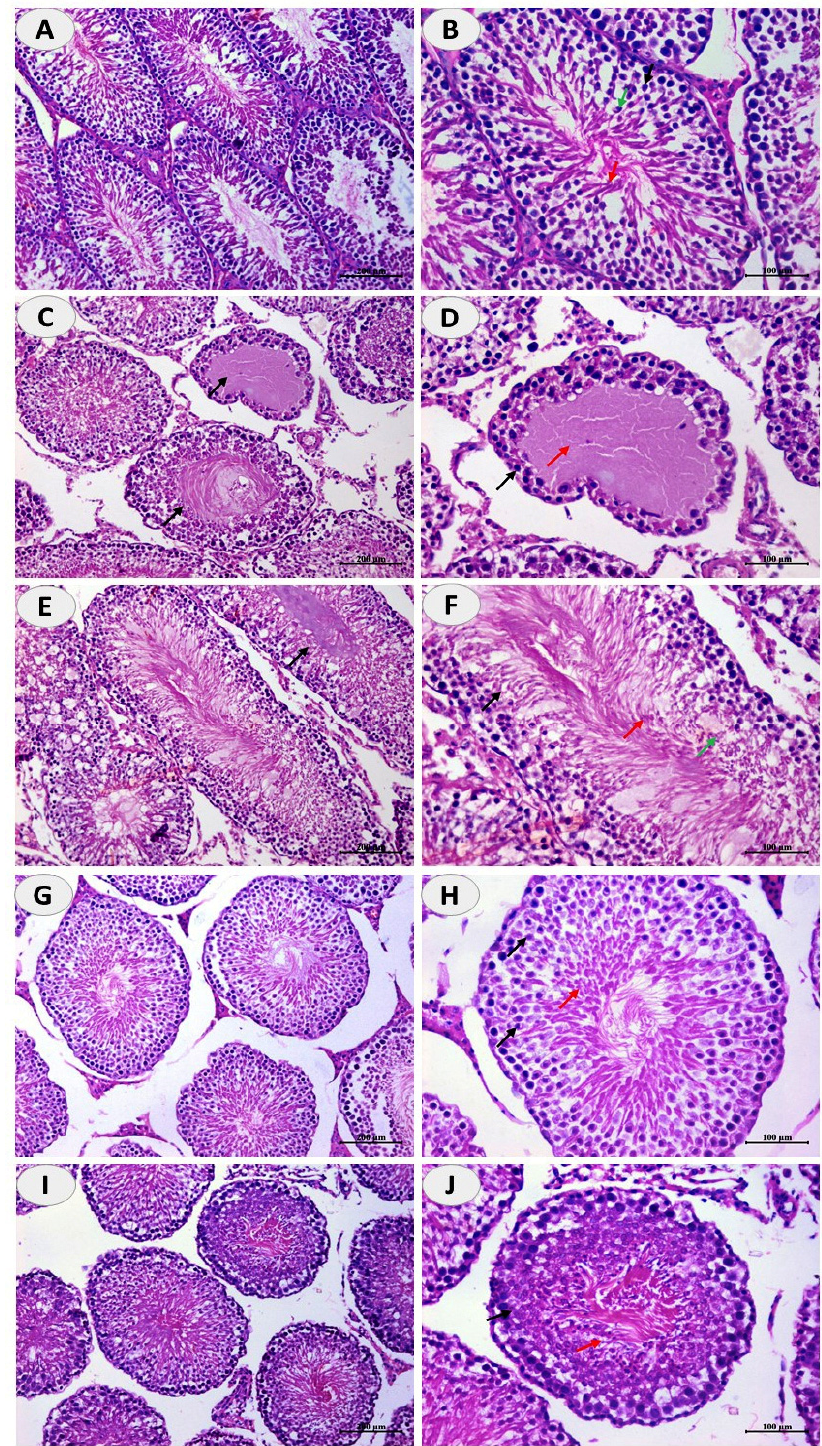
Figure 2. N-CUR and CUR prevent Cu-induced testicular tissue injury. Photomicrographs of H&E- stained sections in the testis of ( A , B ) control rats showing normal histological architecture, ( C , D ) Cu-intoxicated rats showing degenerative changes and loss of spermatogenic series, and spermatozoa, and ( E – J ) Cu-intoxicated rats treated with DFO ( E , F ), CUR ( G , H ), and N-CUR ( I , J ) showing normal seminiferous tubules with spermatogonia, primary spermatocytes, spermatids, and spermatozoa. (×200: A , C , G , E , I . ×400: B , D , F , H , J ).